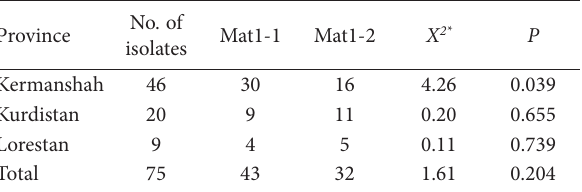
Table 1. Numbers and mating types of 75 Ascochyta rabiei isolates collected from western